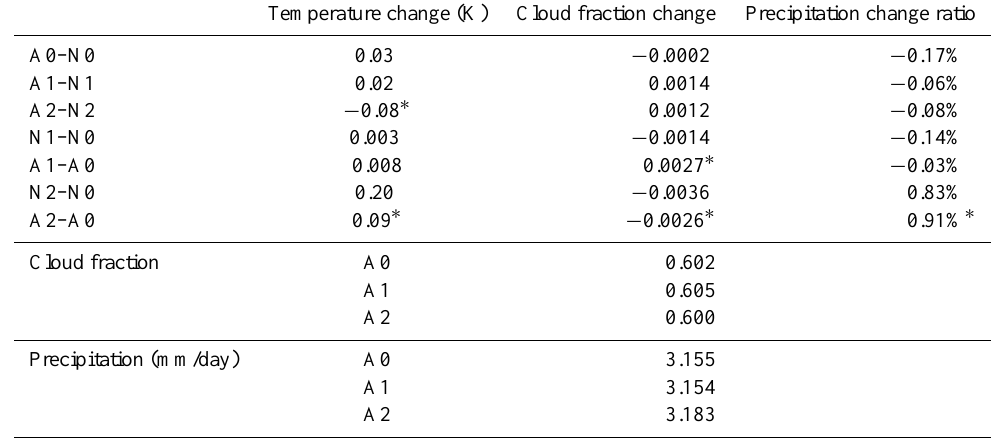
Table 5. Simulated meteorological responses to sulfate radiative forcing over the globe. The symbols representing statistical confidence level are the same as in Table 4. Also listed at the bottom are simulated total cloud coverage and precipitation as a reference for